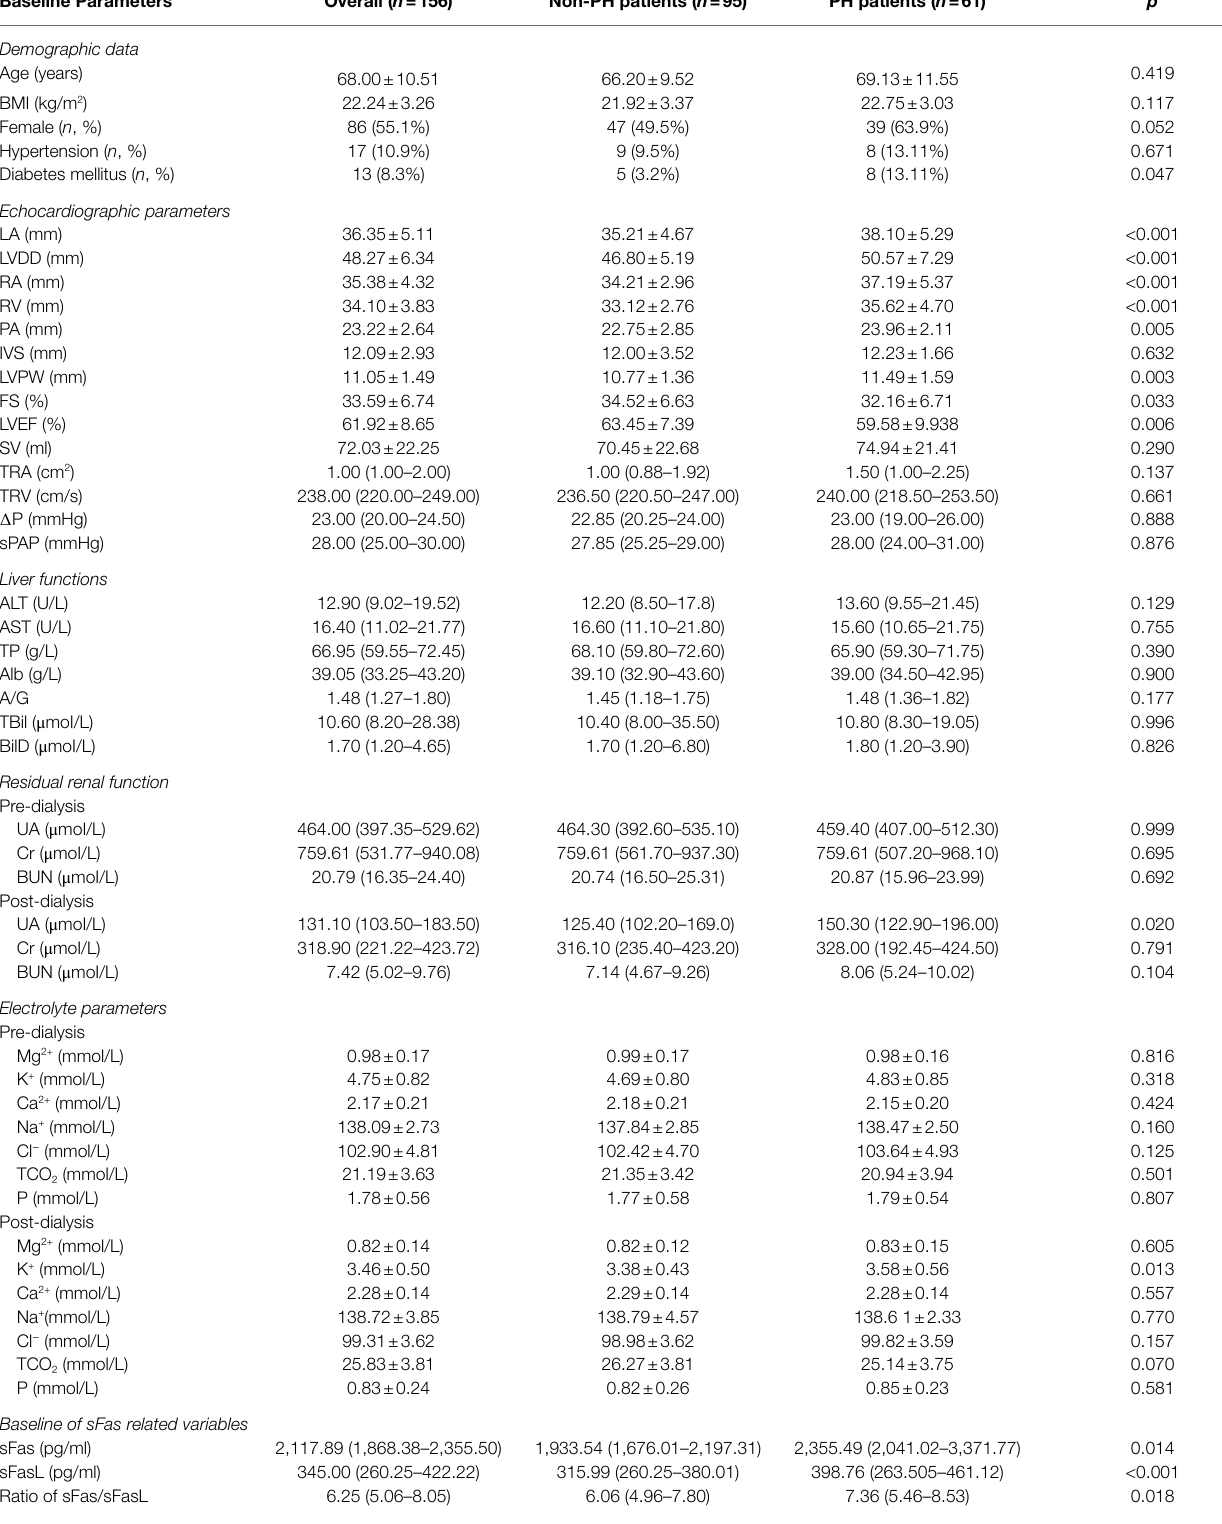
TABLE 1 | Differences of the baseline hemodynamics, demographic data, renal function, ions, and liver function between PH and non-PH groups. Baseline Parameters Overall ( n = 156) Non-PH patients ( n = 95) PH patients ( n = 61)